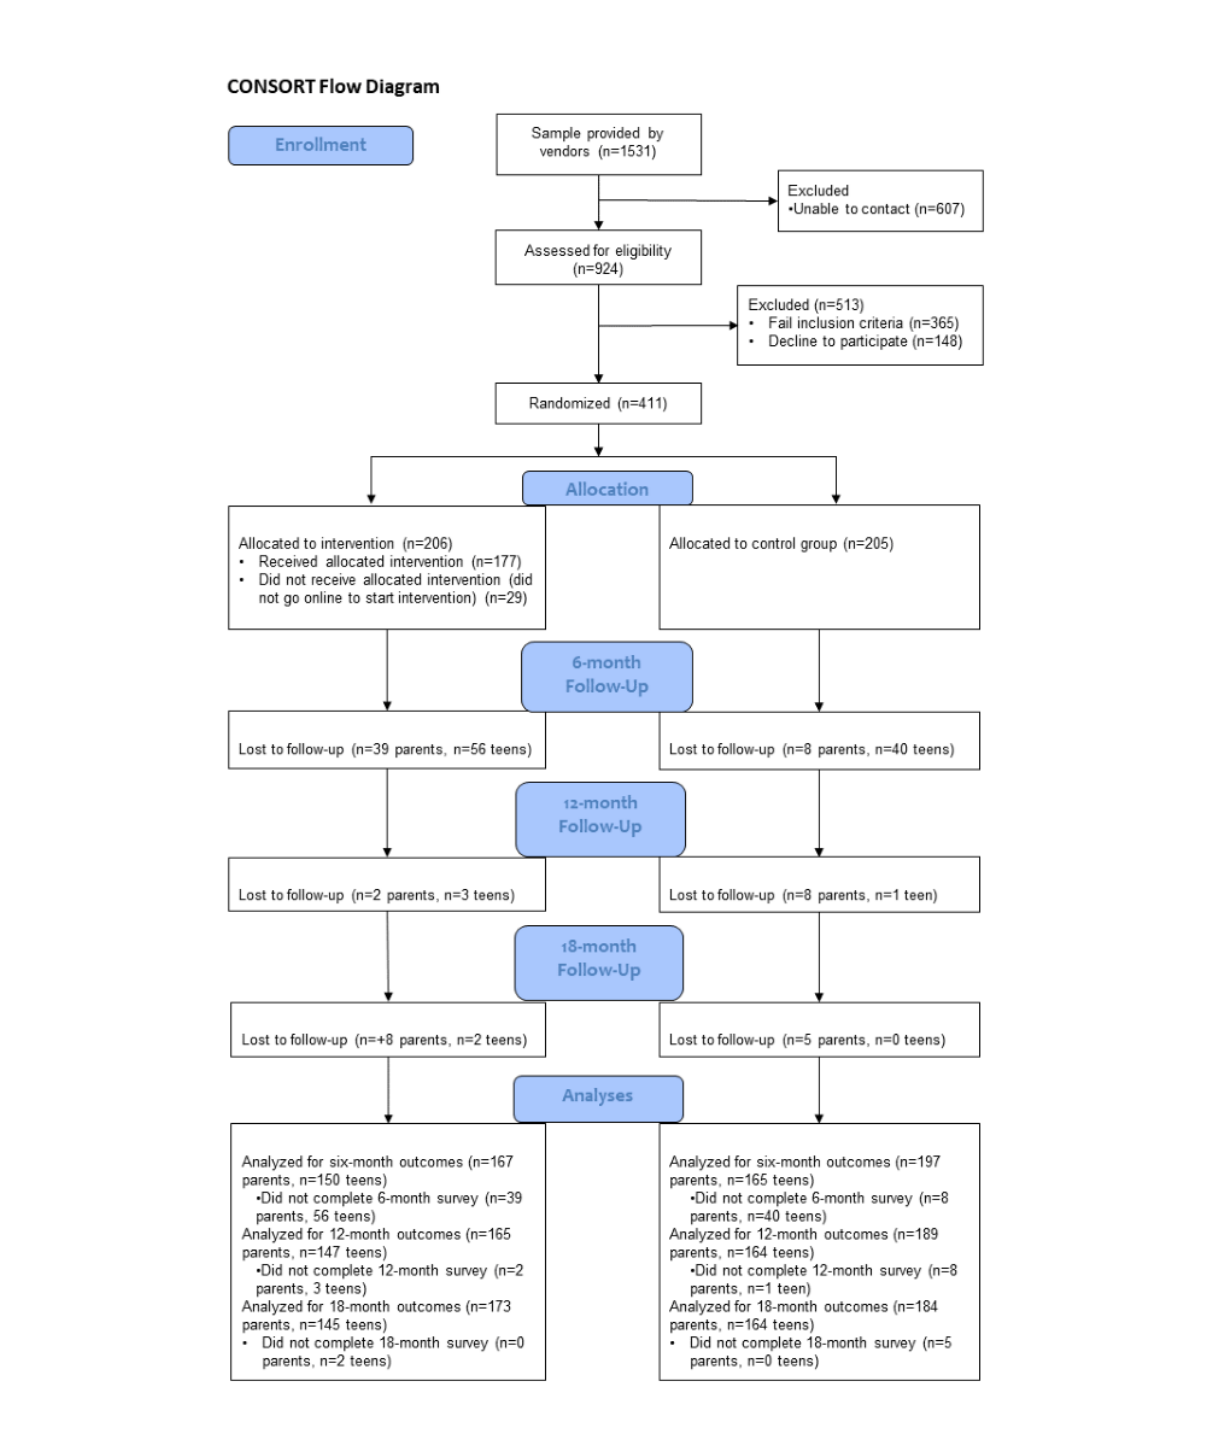
Figure 1. Consolidated Standards of Reporting Trials flow